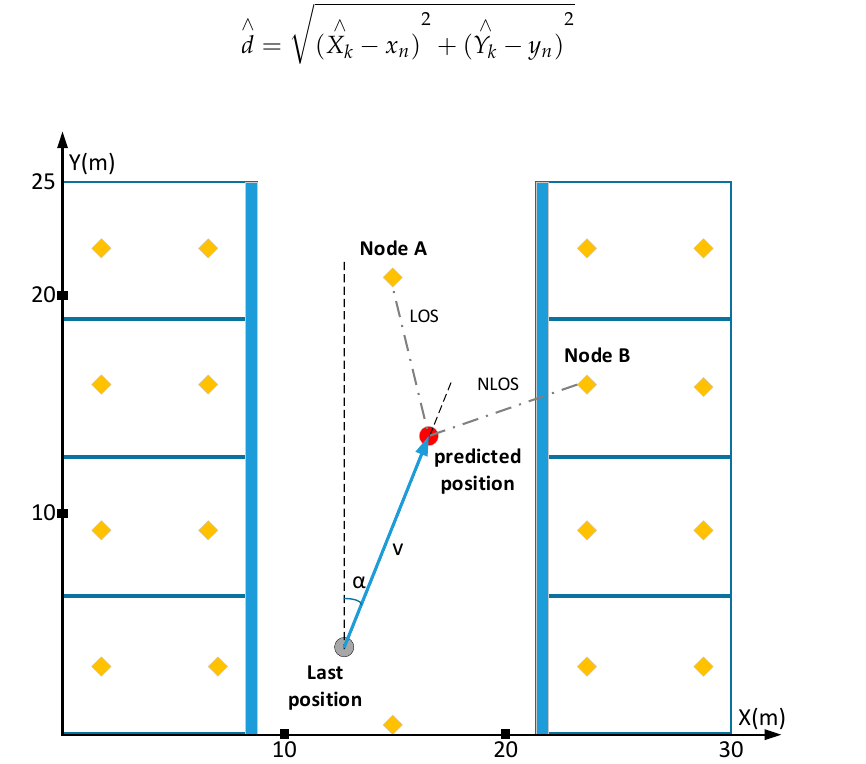
Figure 5. The schematic drawing of our proposed non-line-of-sight (NLOS) identification method. Since the signal will be faded gradually and the intensity will be decreased with extended propagation distance, the final received signal intensity can be used to estimate the transmitter– receiver distance. Generally, the signal propagation model can be expressed as the intensity which is shown in Equation (3) to estimate the transmitter-receiver distance.